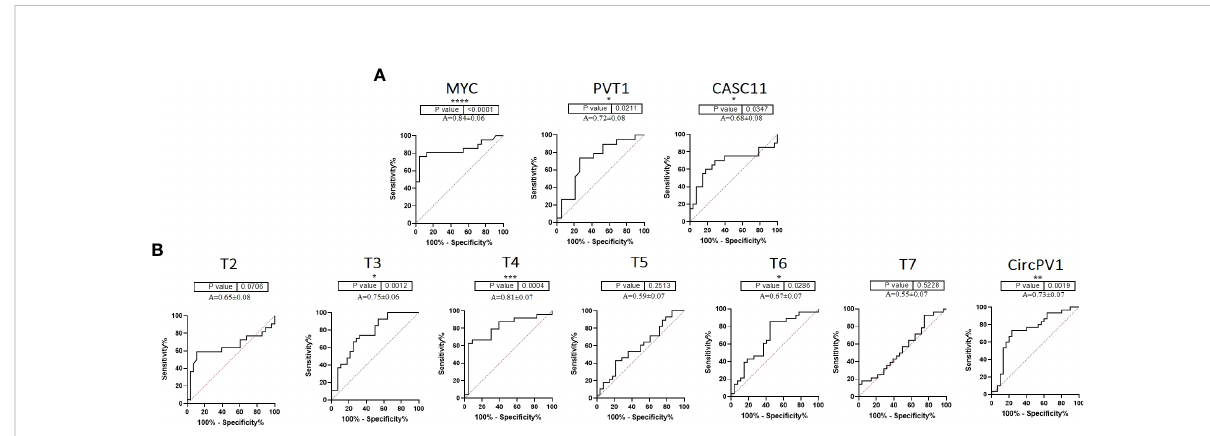
FIGURE 2 ROC curve of PVT1 , CASC11 , and MYC expression in colorectal tumors. (A) PVT1 , CASC11 , and MYC might be considered biomarkers for the early prognosis of colorectal cancer. (B) According to the ROC curves of PVT1 transcripts in colorectal tumors, T3 , T4, T6, and CircPVT1 might be useful in the early detection of malignancy *P<0.05, **P<0.01, ***P<0.001, ****P<0.0001.